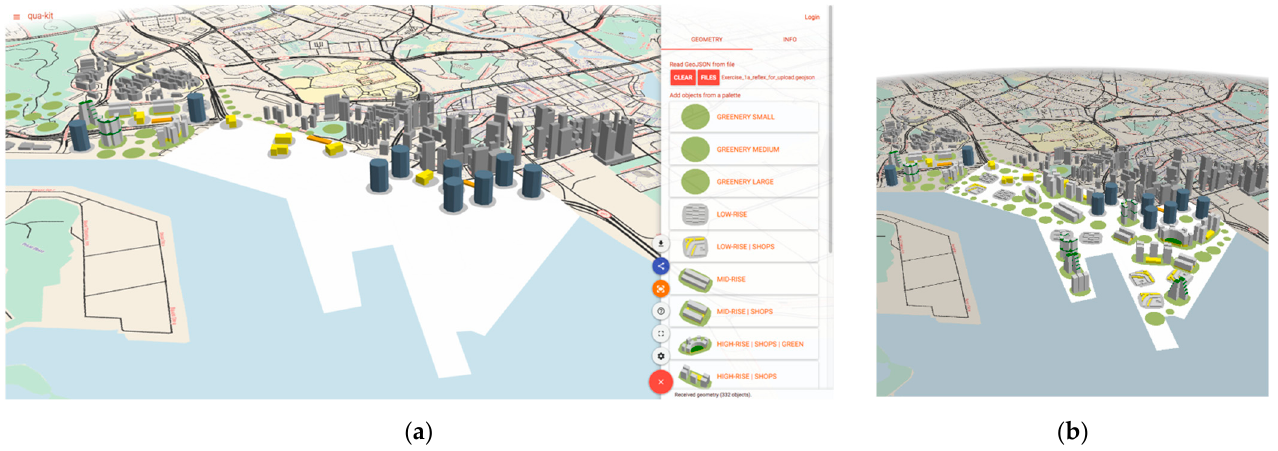
Figure 1. ( a ) Screenshot of the Quick Urban Analysis Kit (qua-kit) user interface. ( b ) Design proposal of one participant which is used as an example for demonstration of evaluation methods of individual submissions in this article .